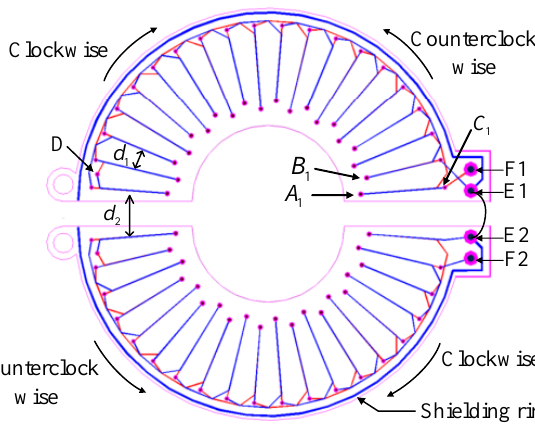
Figure 13. Schematic diagram of the winding mode of the open-ended PCB Rogowski coil .